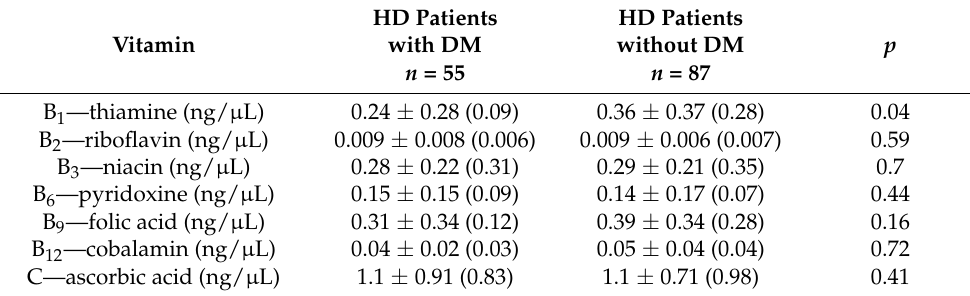
Table 5. Comparison of blood vitamin levels between HD patients with and without DM. HD Vitamin